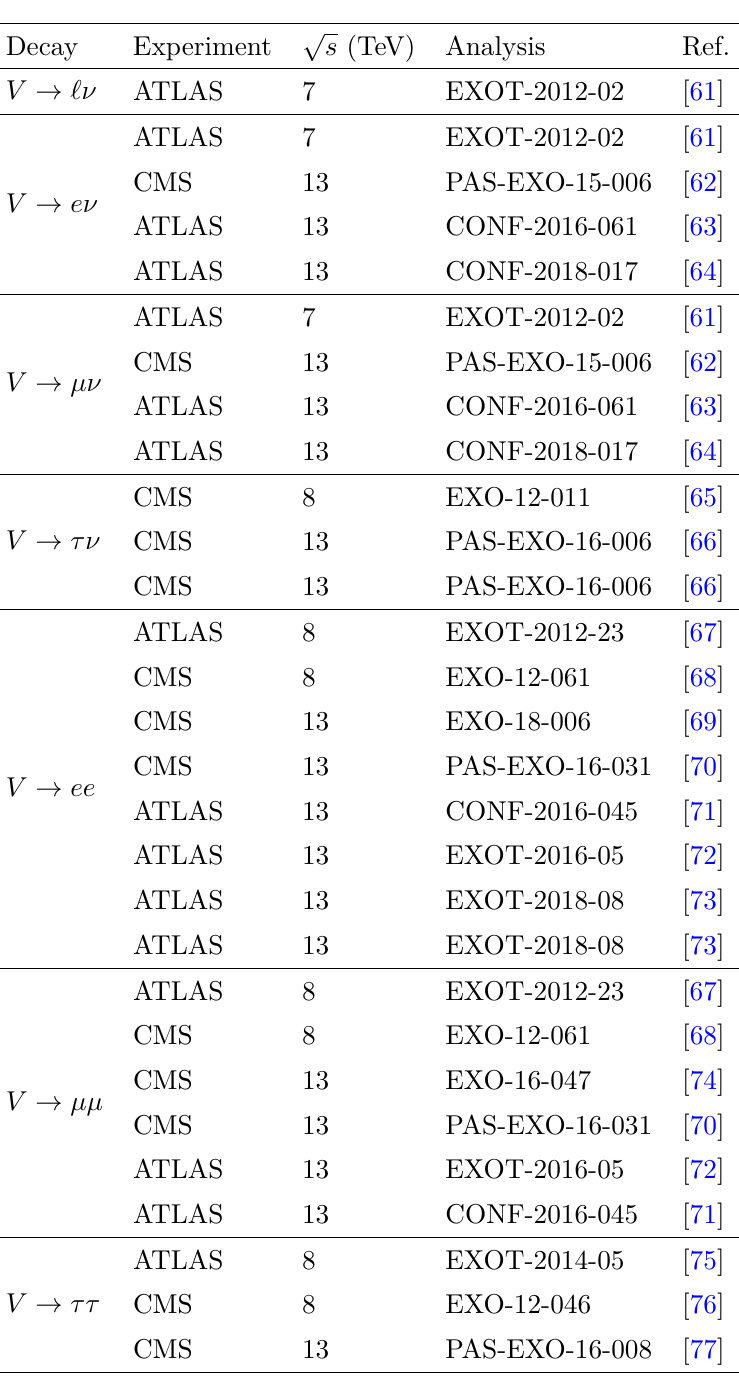
Table 7. Experimental analyses of leptonic decay channels of vector resonances we use to judge the fitness of our